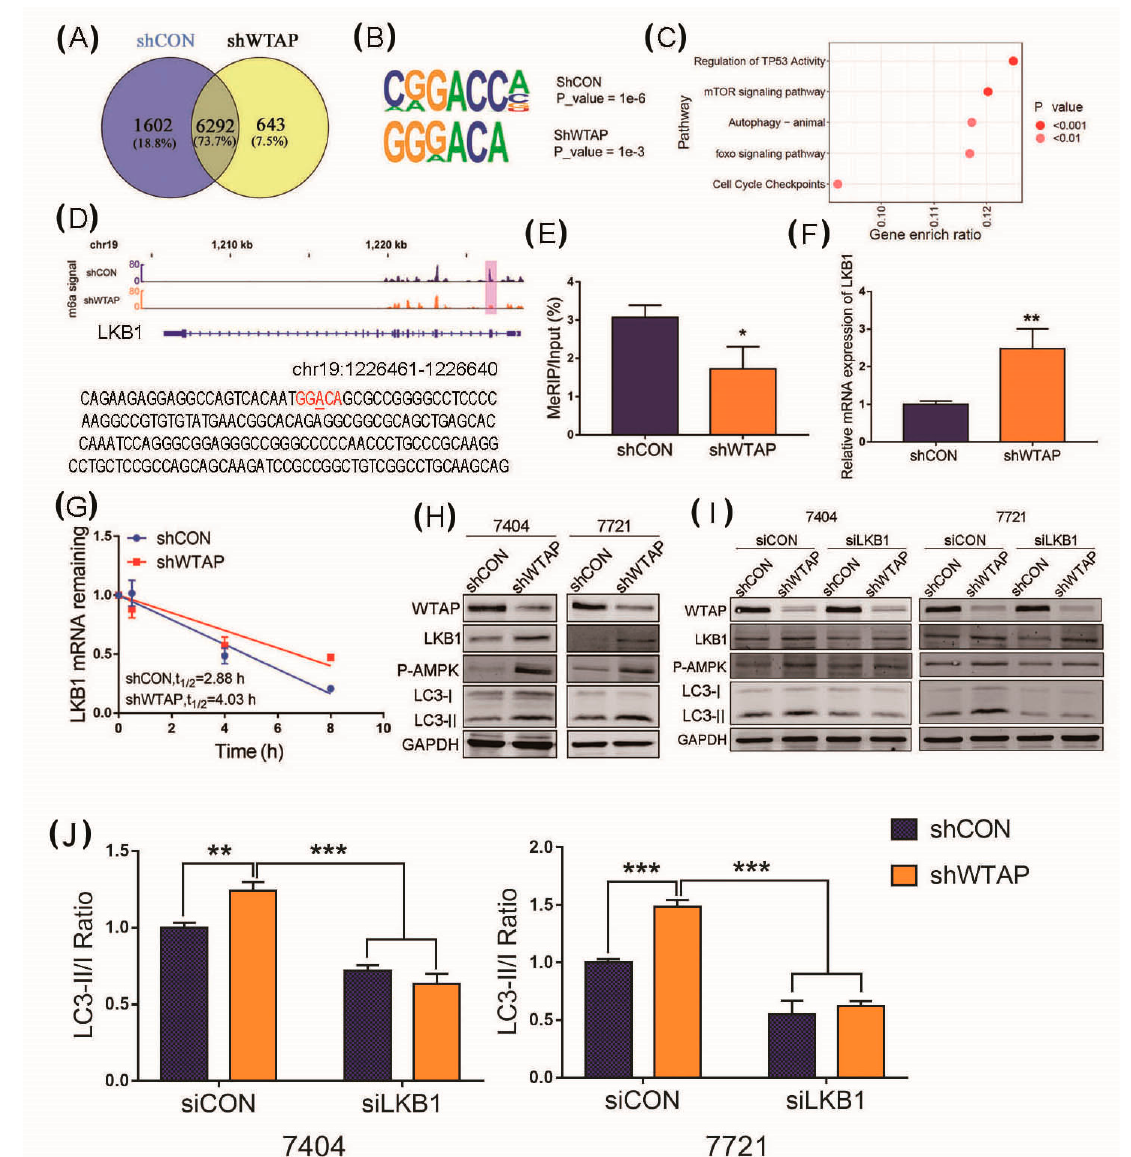
Figure 4. Knockdown of WTAP facilitating autophagy through upregulation of LKB1. ( A ) Venn diagram showing the difference in m 6 A peaks between shCON and shWTAP cell lines. ( B ) Conserved m 6 A motif found in schON and shWTAP HCC cell lines. ( C ) Signal pathway analysis of the different m 6 A modified genes between shCON and shWTAP HCC cell lines. ( D ) The m 6 A motif found in LKB1 transcript through sequencing. ( E ) MeRIP-qPCR analysis of cellular m 6 A levels in shCON and shWTAP HCC cell lines. ( F ) RT-qPCR used for the abundance analysis of LKB1 transcript in shCON and shWTAP HCC cell lines. ( G ) Half-life analysis of RNA stability of LKB1 transcript in shCON and shWTAP HCC cell lines. ( H ) Western blot analysis of LKB1, p-AMPK, LC3-I and LC3-II in shCON and shWTAP cells. ( I ) Western blot analysis of LKB1, p-AMPK, LC3-I and LC3-II in shCON and shWTAP cells, as well as in siLKB1 cells. ( J ) Statistical analysis of LC3 -II/LC3-I ratio between shCON and shWTAP-treated 7404 and 7721 cell lines. Error bars indicate the mean ± SD from three independent experiments ( n = 3). * indicate a statistically significant difference ( p < 0.05) and ** indicate a statistically significant difference ( p < 0.01), *** indicate a statistically significant difference ( p <